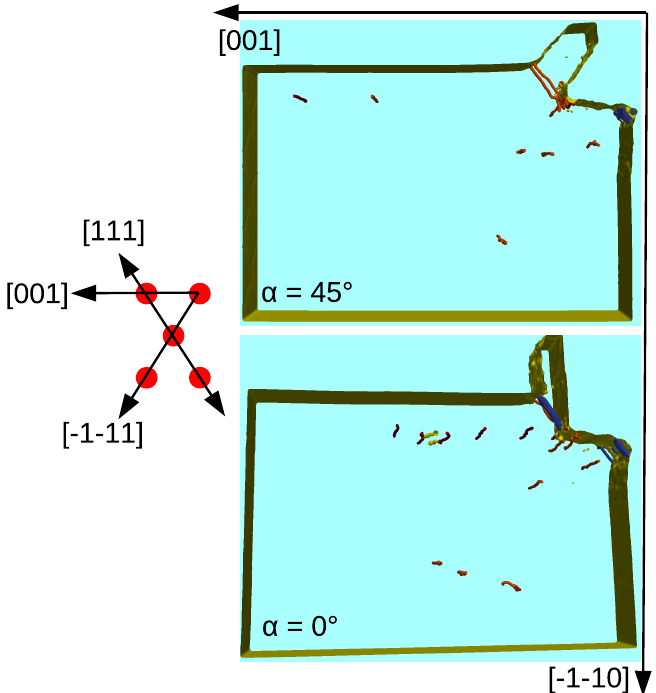
Figure 2. Side view of the dislocations generated in the Fe crystal after a cutting length of 100 Å with a cutting tool of rake angle 45 ◦ and 0 ◦ . On the left-hand side, an atomistic sketch shows a 2D bcc unit cell in the plotted plane that explains the slip directions. Yellow: deformed surface including unidentified defects. Color code for dislocations classified by the Burgers vector b : red: b = (cid:104) 100 (cid:105) ; (cid:104) 111 (cid:105) ; blue: b = 1 (cid:104) 111 (cid:105) partial with p = 3, 6, or orange: b = 1 p 2